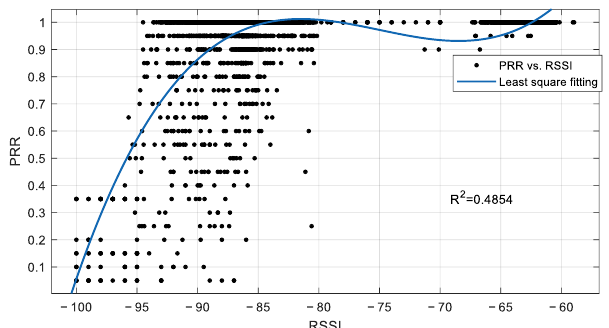
Figure 2. Fitting diagram of the RSSI and PRR.